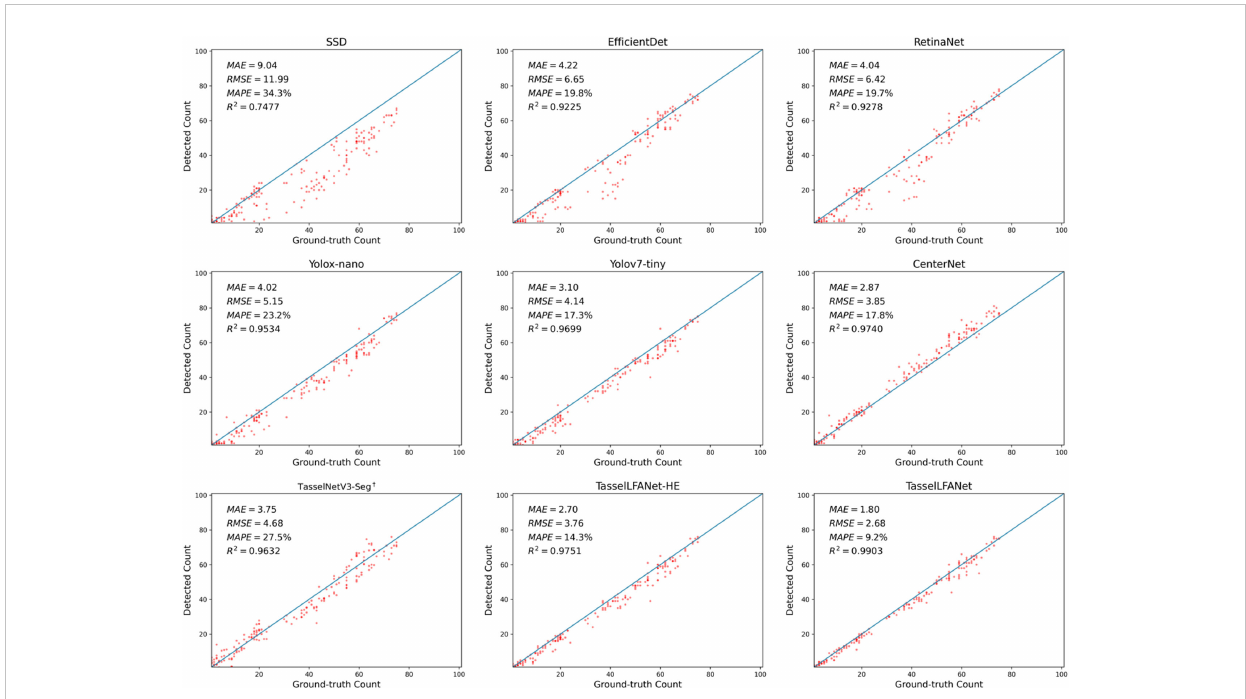
FIGURE 9 Scatter plots of the detected count by different models versus their ground-truth